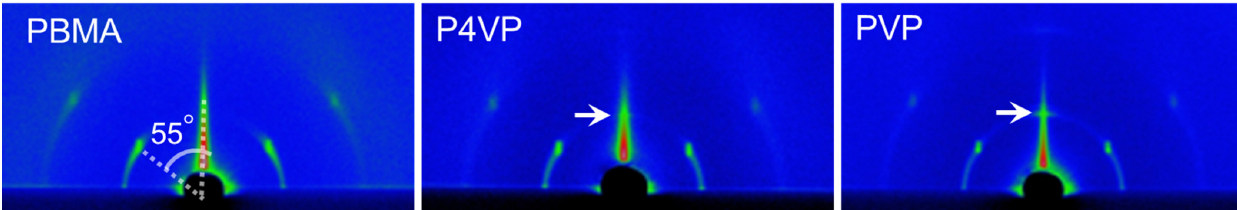
Figure 5. 2D GI-SAXS data for thicker PAz films (thickness: 400 nm) covered with PBMA ( left ), P4VP ( middle ) and PVP ( right ) layer on top at room temperature. For the white arrow, see the